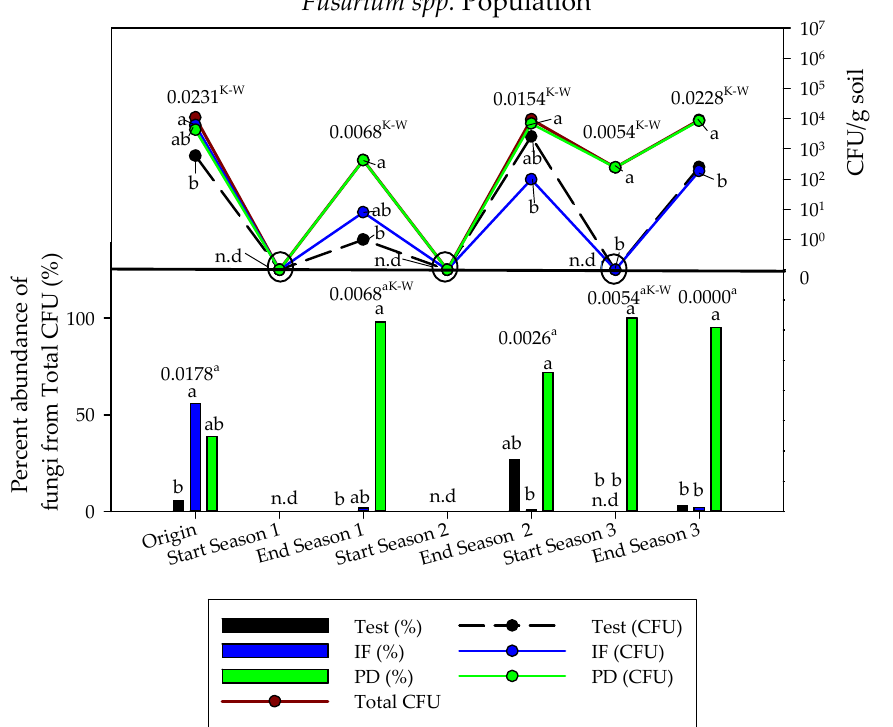
Figure 4. Soil Fusarium microbiota in the three years of study (September–April cycles) as a function of crop nutrition. Inorganic fertilization (IF; n = 4); tomato plant debris (PD; n = 4); no fertilization (Test; n = 4). N.d: not detected. Values (average). Different letters above the bars and in the evolution lines indicate significant differences. ( p ≤ 0.05, Tukey’s HDS test), a : 𝑎𝑟𝑐𝑠𝑒𝑛(cid:3435)√𝑥(cid:3439) ; K-W : Kruskal–Wallis test.